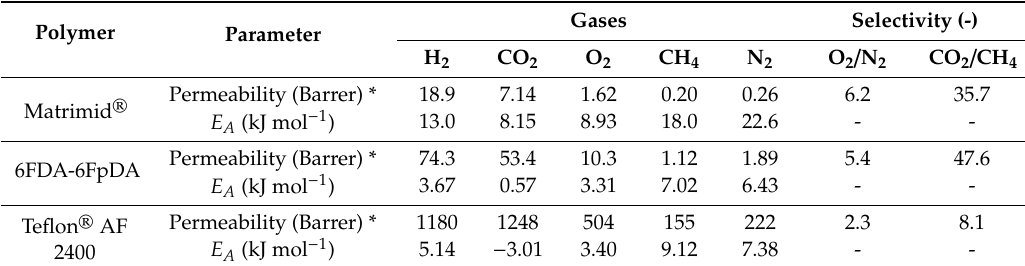
Table 1. Separation properties for the thick films at 30 ◦ C and the activation energy calculated in the temperature range 30–70 ◦